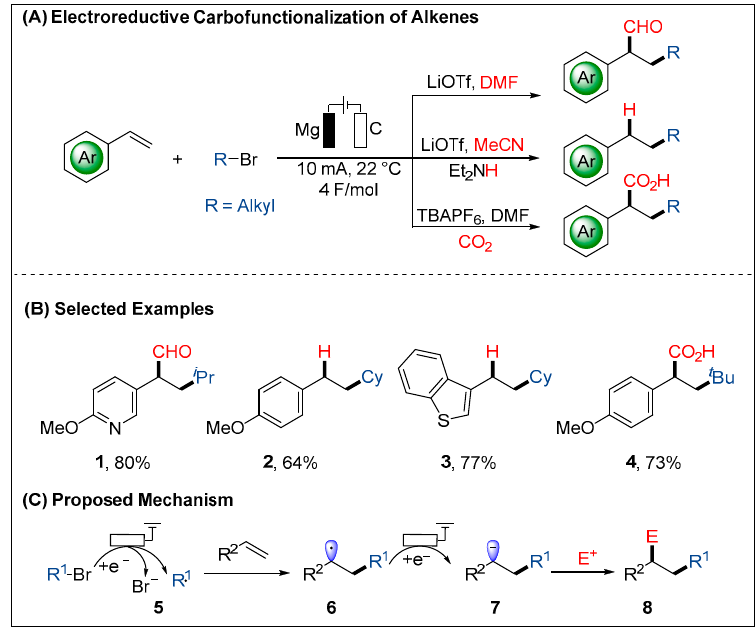
Figure 3. Electroreductive reaction of alkyl halides with alkenes.